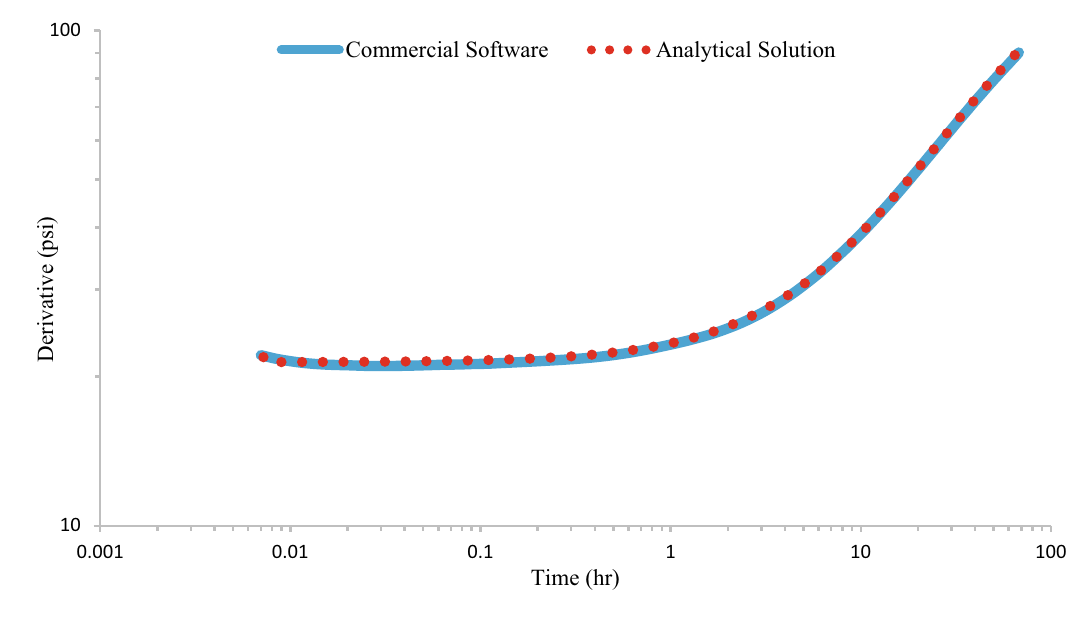
Fig. 9 Matching analytical and numerical pressure derivative plots in log–log scale of the scenario No. 3 in homogenous reservoir